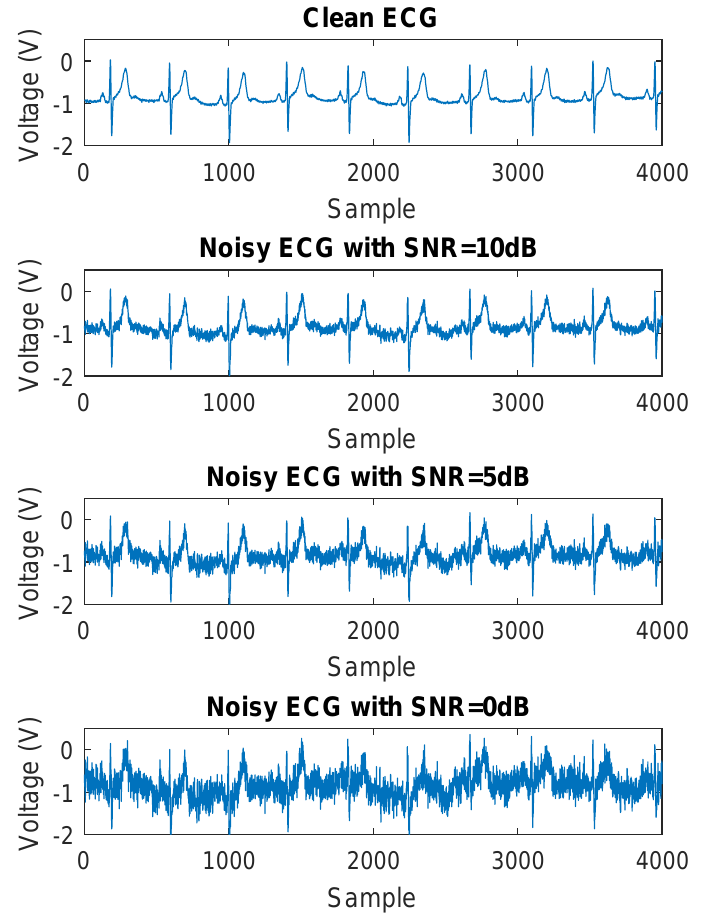
Figure 5. Artificially contaminated ECG signals with different SNR